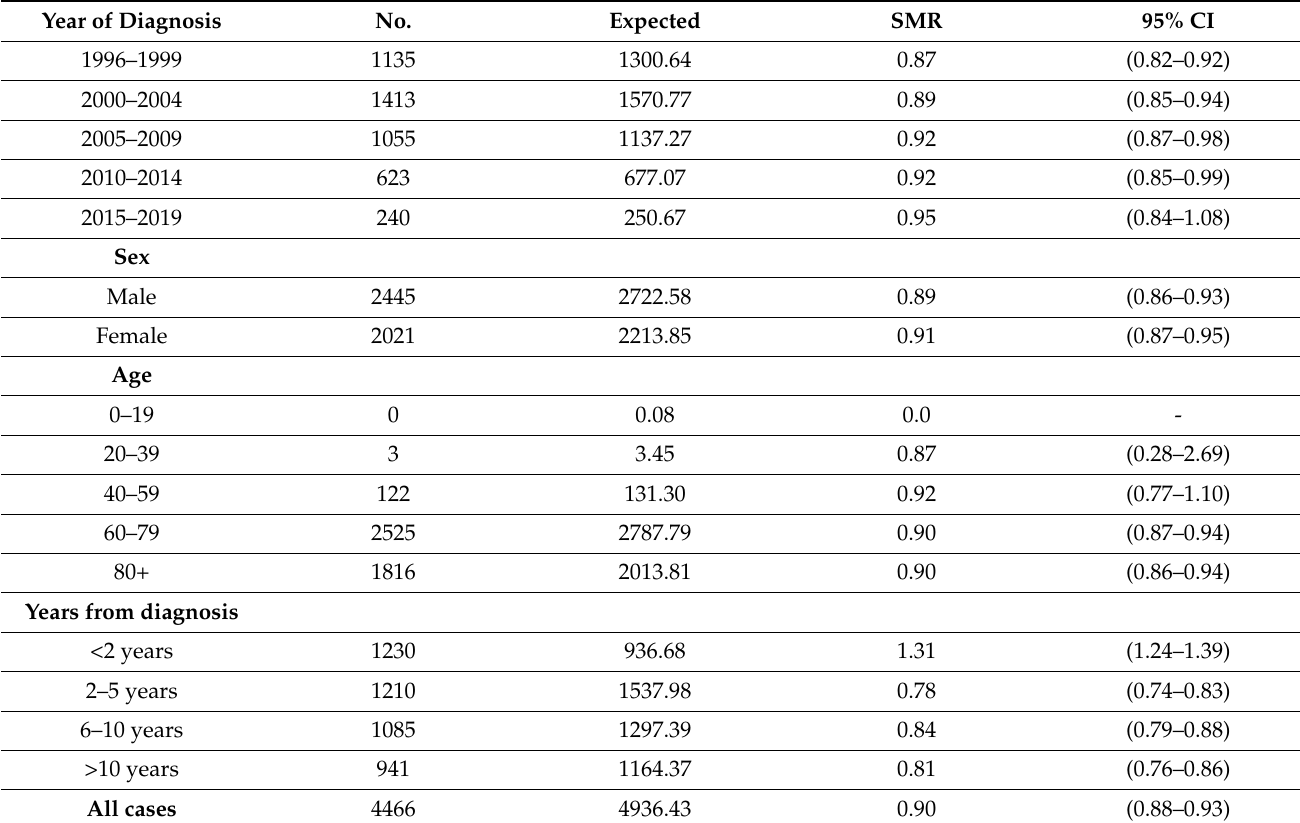
Table 2. Standardized mortality ratio (SMR) of risk of dying from cardiovascular disease among cancer survivors compared with that of the general population. SMRs presented by year of cancer diagnosis, sex, age, and years from diagnosis. Reggio Emilia, Italy,